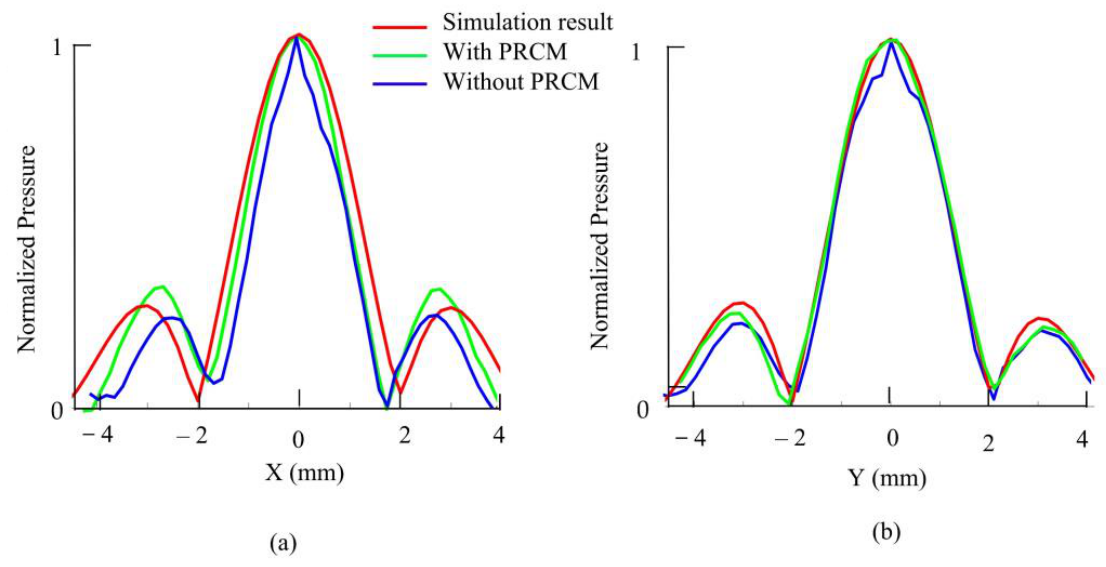
Figure 5. The comparison of beam size in cross plane at focus: ( a ) the O-XY plane view; ( b ) the O-XZ plane view.